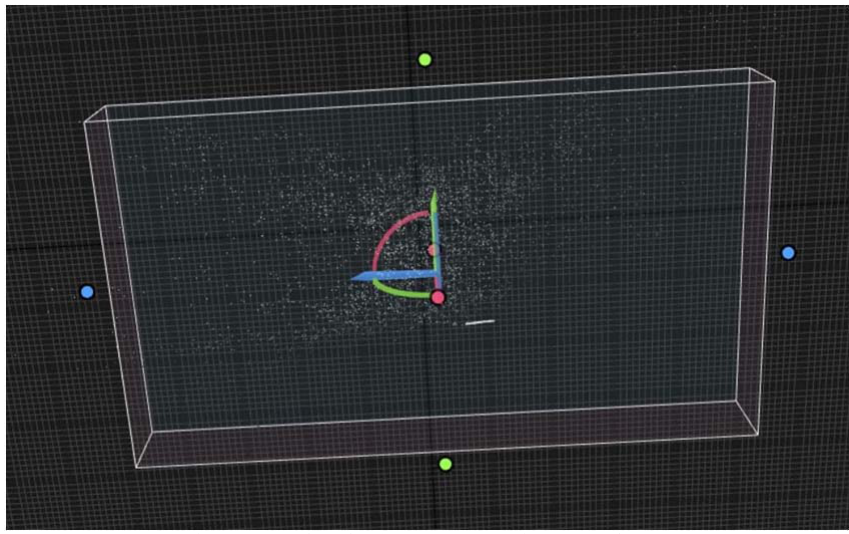
Figure 9. Cloud of common points on photos